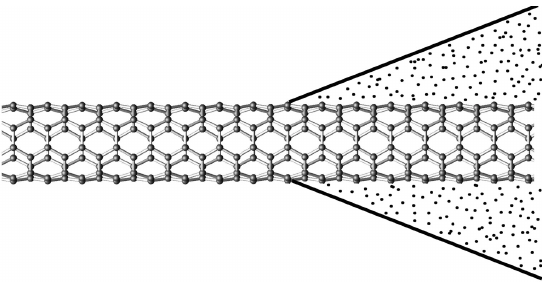
Figure 3. Schematic diagram of the thermal rectifier with amorphous C9H16Pt deposited at one end of the nanotube. Reprinted with permission from the American Association for the Advancement of Science.